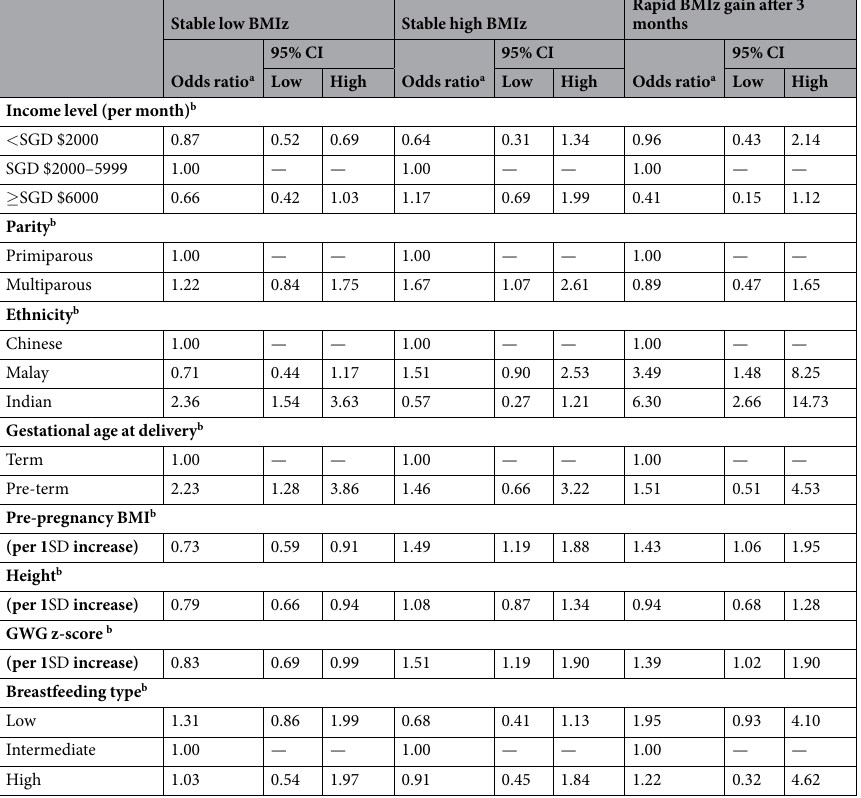
Table 2. Predictors of BMI z-score trajectory groups in the first 2 years of life. a Odds ratio estimates are referenced to the normal BMI z-score trajectory. b All predictor variables are simultaneously included in the regression